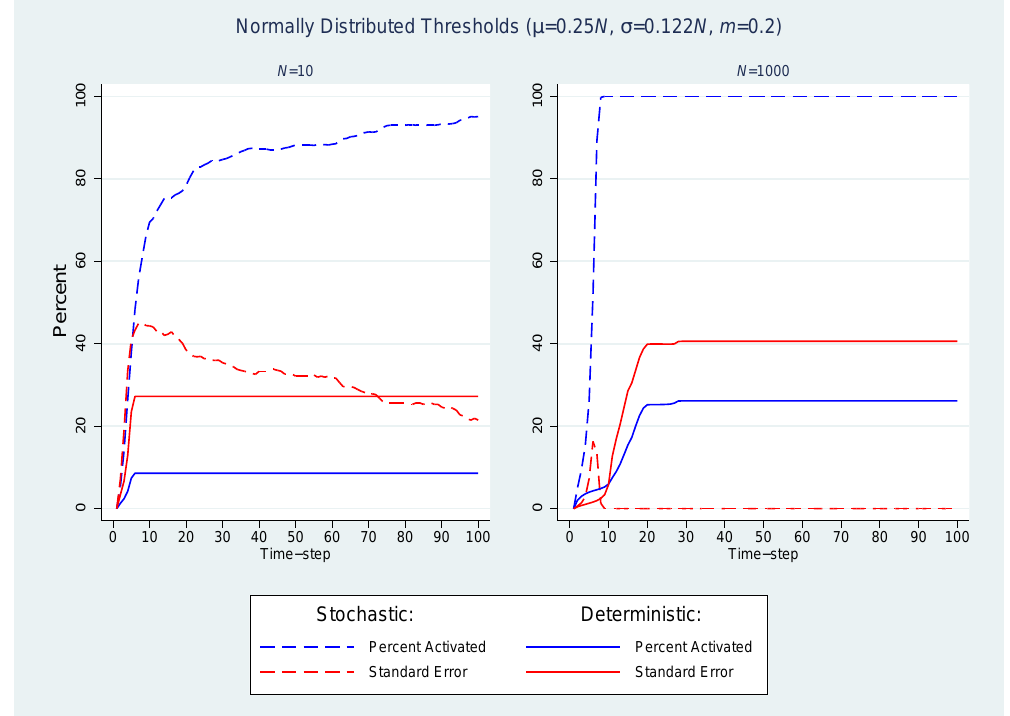
Figure 5: Unpredictability of activation level as N increases from 10 to 1,000. Group size is an order of magnitude above and below the size reported in Figure 3. Unpredictability is measured as the observed standard error of the mean activation level across 100 samples with µ = 0.25 N and σ = 0.122 N randomly drawn from a normal threshold distribution. With deterministic thresholds, the equilibrium activation level increases from 8 percent with N = 10 to 26 percent with N = 1, 000, with an increase in unpredictability from 28 percent with N = 10, to 41 percent with N = 1, 000. In contrast, unpredictability decreases with group size if thresholds are stochastic ( m = 0.2). With N = 1, 000, the standard error decreases to zero within 10 time steps, whereas with N = 10, the standard error dropped below that for deterministic thresholds only after 75 time